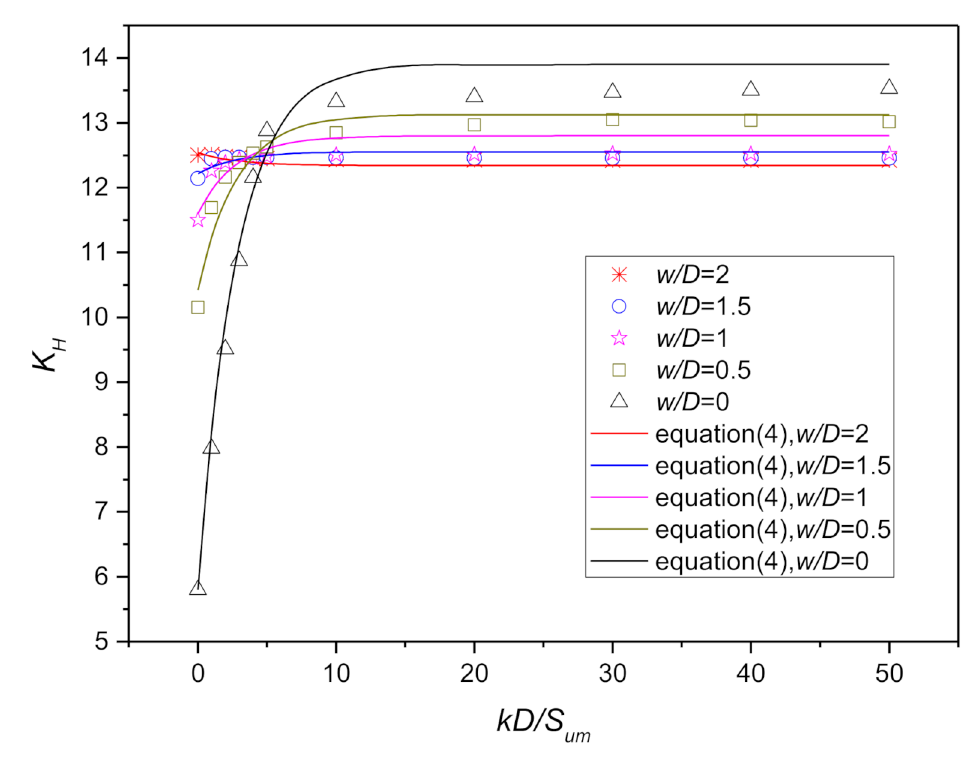
Figure 14. Vertical dimensionless elastic stiffness coefficients with complete backflow of soil.